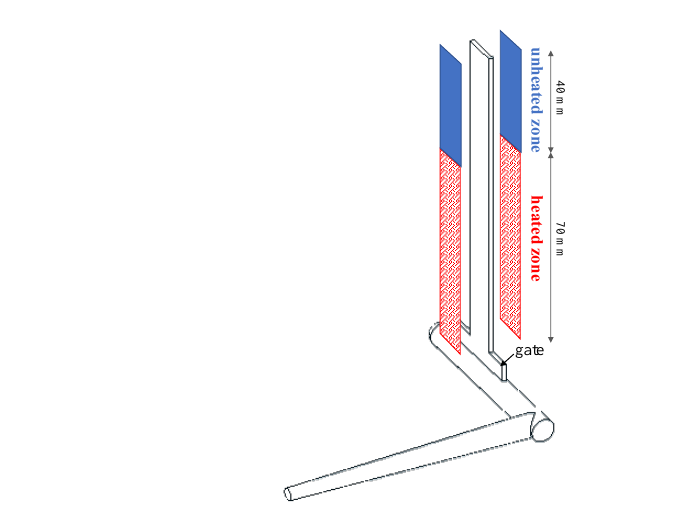
Figure 1. Sketch of the cavity adopted for the injection molding tests, with the heating device.